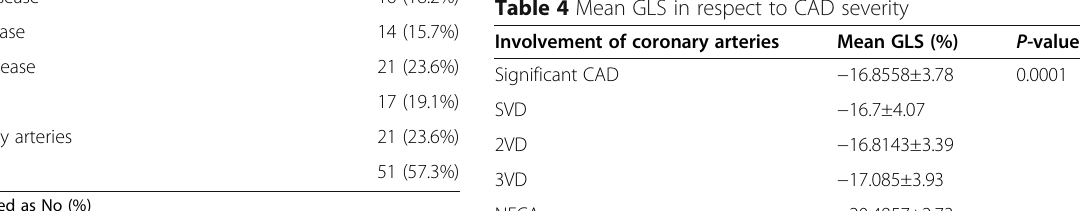
Table 4 Mean GLS in respect to CAD severity